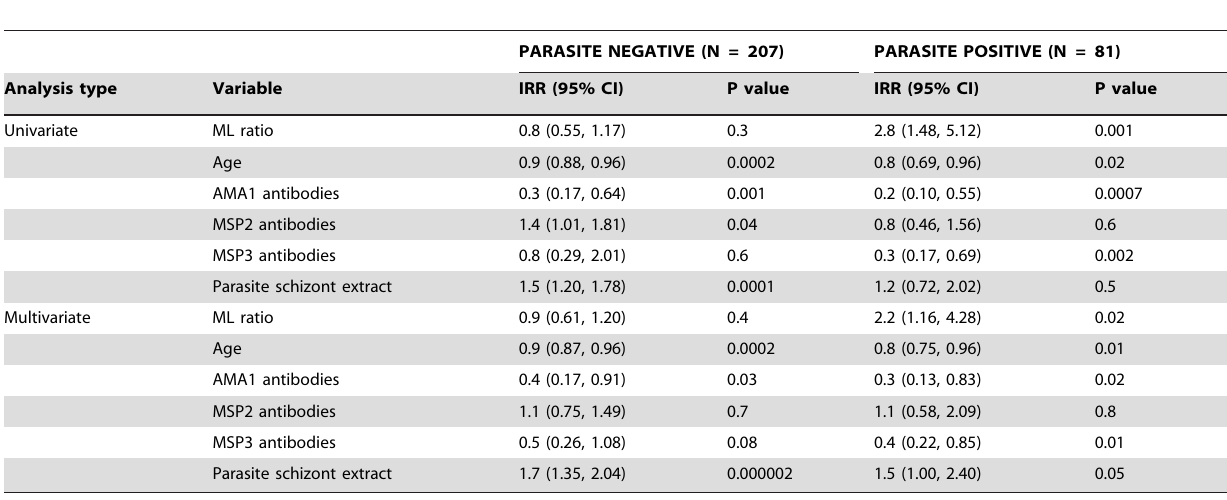
Table 2. The association between risk of malaria and ML ratio is independent of age and antibodies to parasite blood-stage antigens.